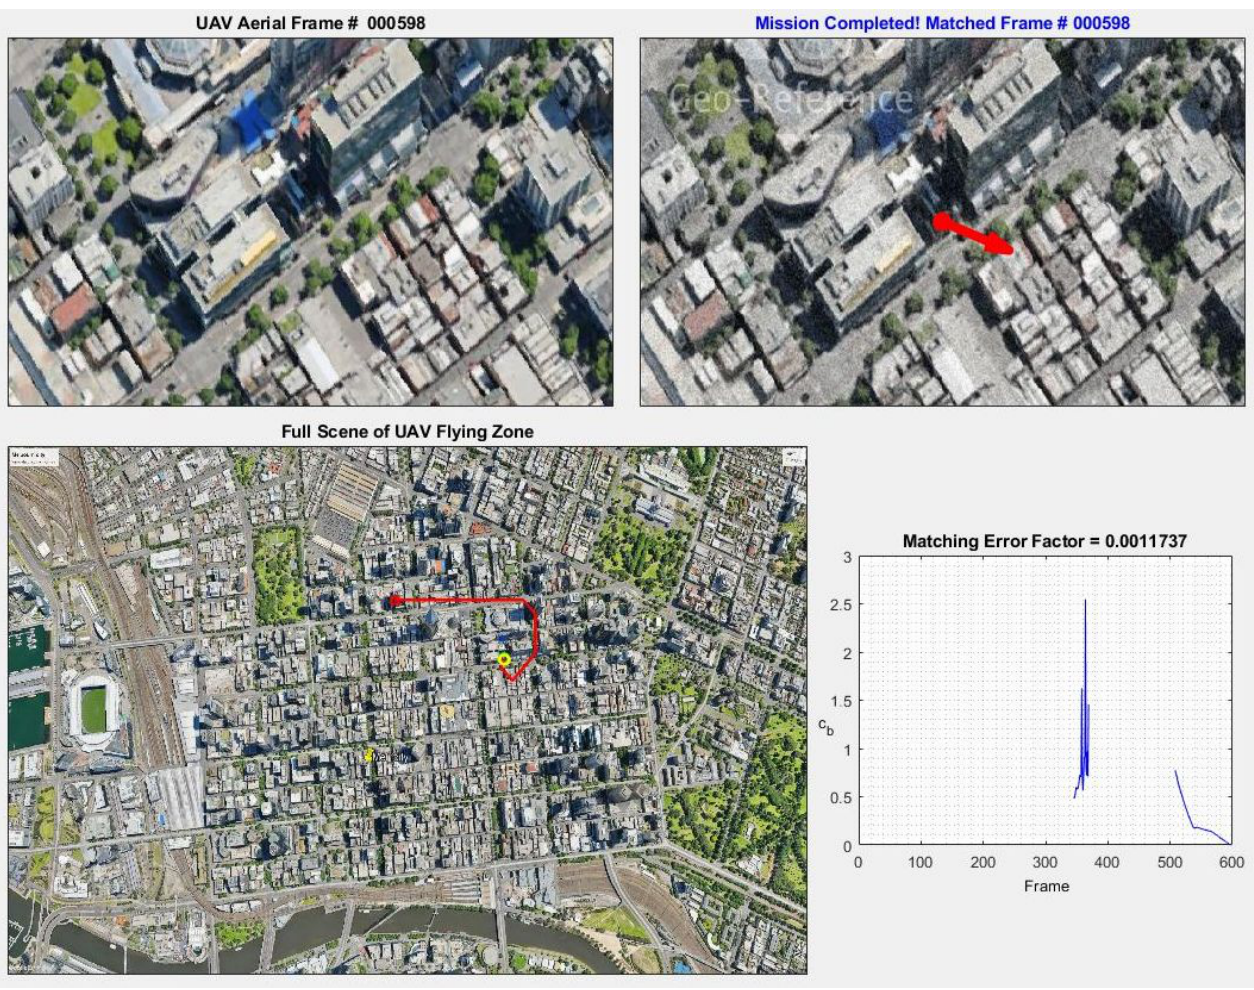
Figure 9. The top left is the UAV aerial camera view window. The top right displays the process of UAV localization when the image registration algorithm captures the scene of reference image. The bottom left is the full view of UAV flying zone image, where the green circle is the location where the reference image was taken, the red square is the UAV takeoff location and the yellow circle represents the flying UAV with its trajectory highlighted by a red curve. The right lower corner window plot the normalized matching accuracy c b when the UAV enters into localization mode. The discontinuity of c b curve signifies that this particular localization process experienced two